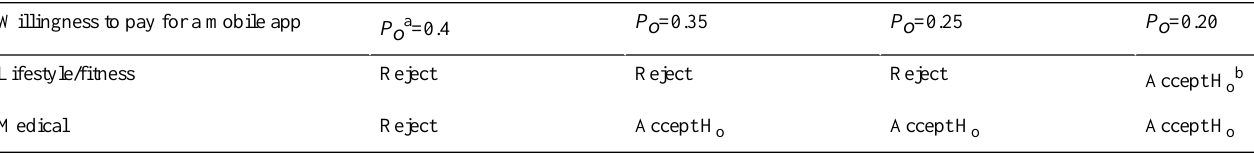
Table 3. Population proportion test for willingness to